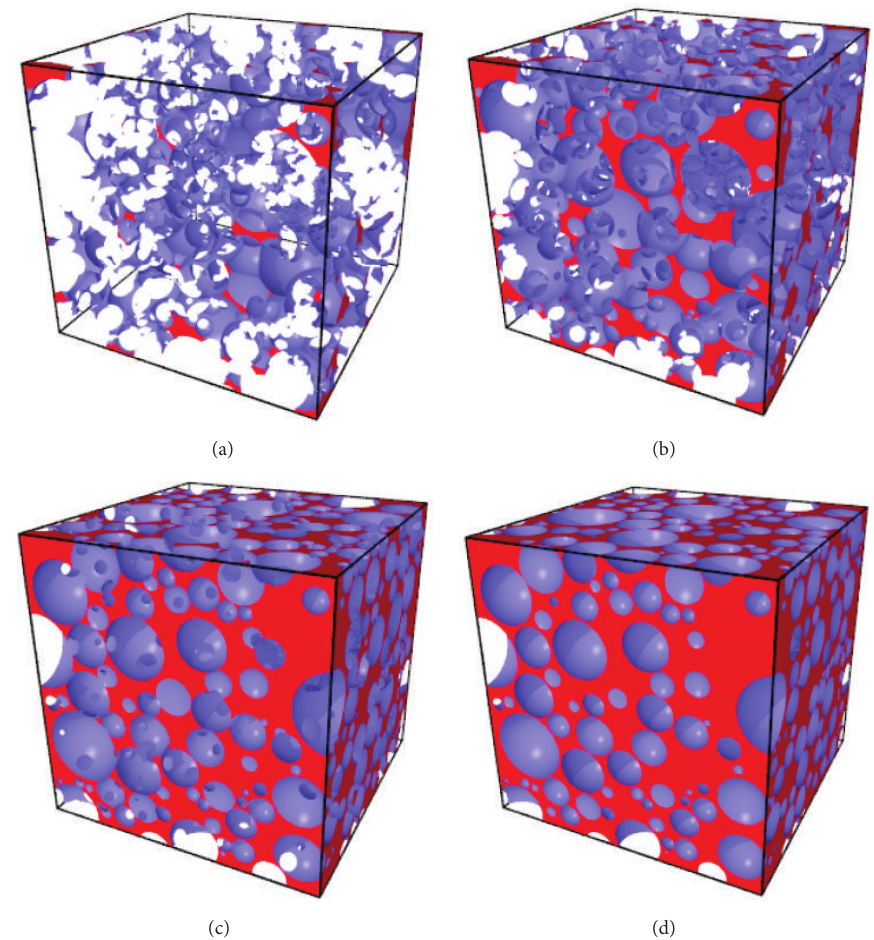
Figure 4: Models for porous media generated using the cherry-pit model; Gamma distributed pore size; mean pore size 𝑟 = 1 , and variance = 0.60 ; 𝜆 = 0.75, 0.85, 0.95, 1.00 for ((a), (b), (c), and 𝜎 2 = 0.5 ; packing fraction of the pit system 𝜙 ℎ